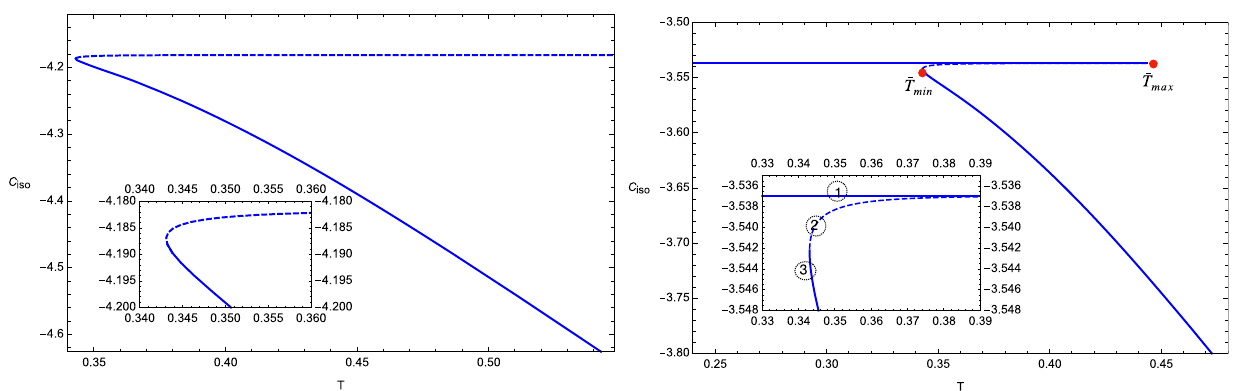
Fig. 3 Left: C iso as a function of temperature for μ = 0 and l = 0 . 5. Right: the dependence of C iso on temperature at fixed μ = 0 . 01 and l = 0 . 5 Fig. 4 C iso in terms of temperature at l = 0 . 5 for three values of μ